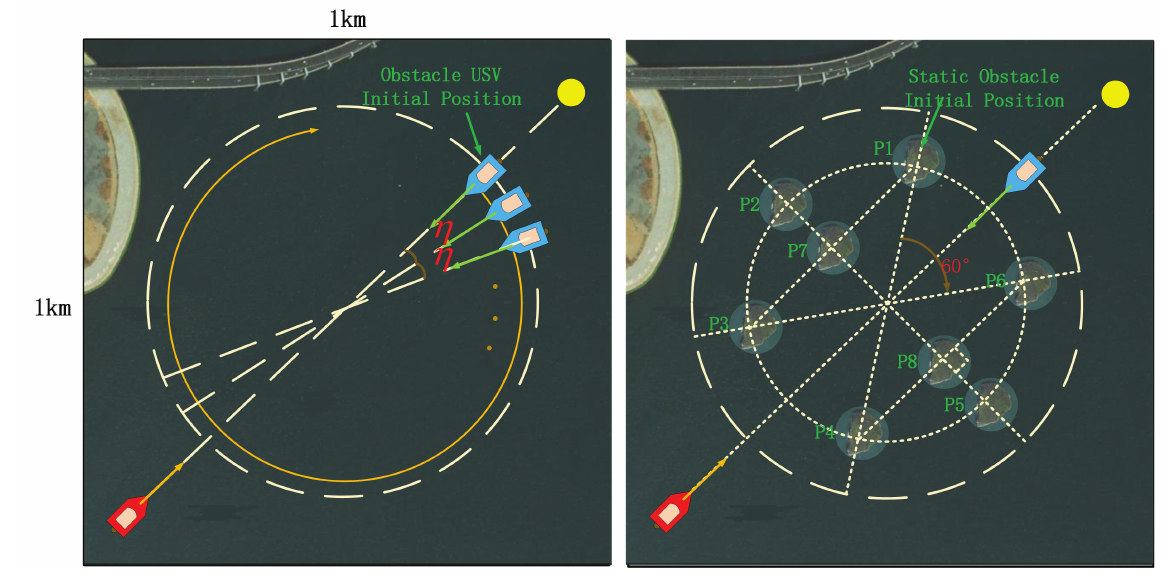
Figure 6. Training environment.